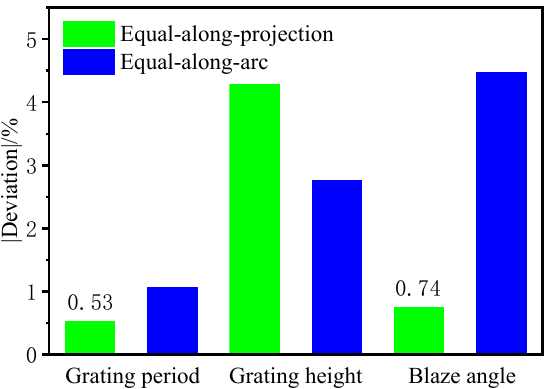
Figure 13. Comparison of dimensional deviations of blazed grating at different layouts.